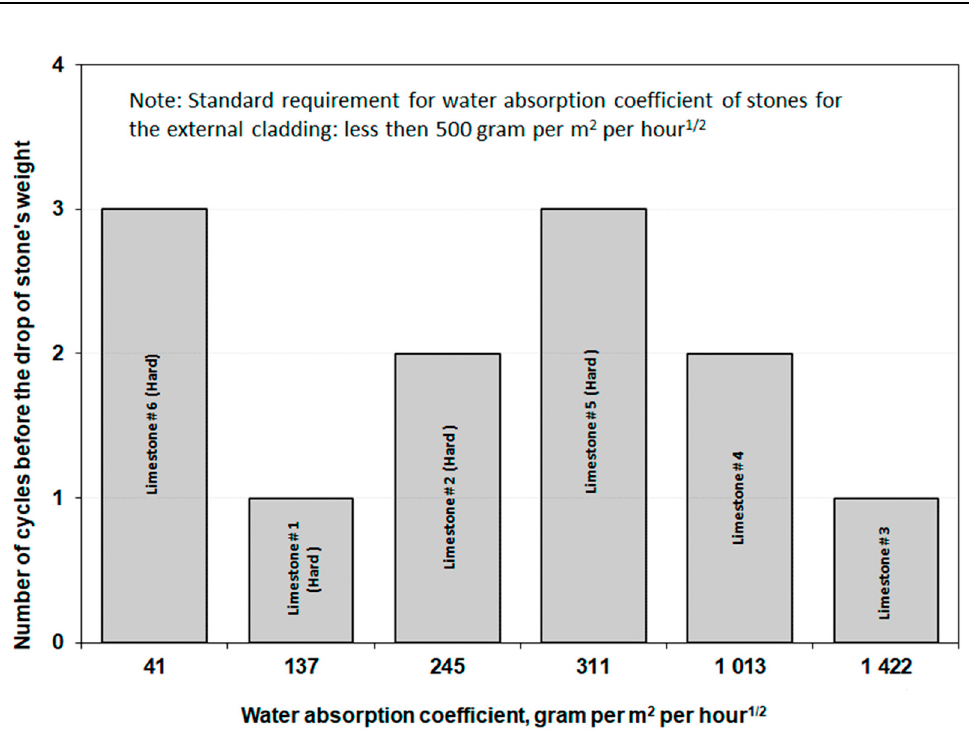
Figure 4. Relationship between the critical content of sodium sulfate and capillary water absorption of limestones.